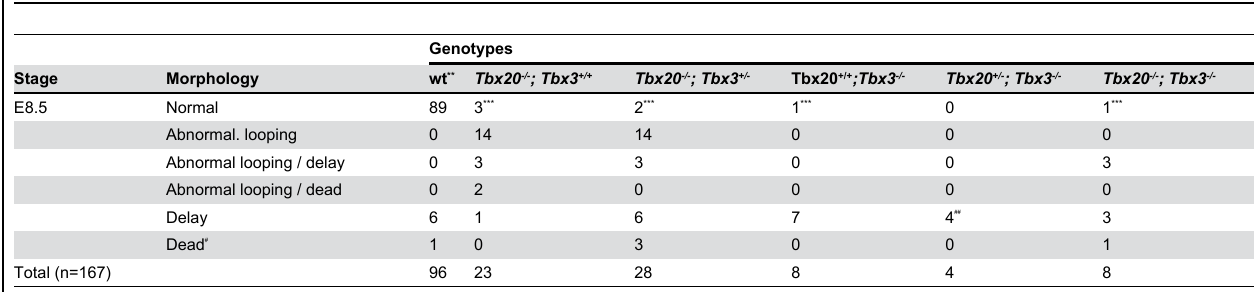
Table 2. Frequency of different morphological defects in embryos at E8.5 from matings of Tbx20 +/- ; Tbx3 +/- double heterozygotes * .